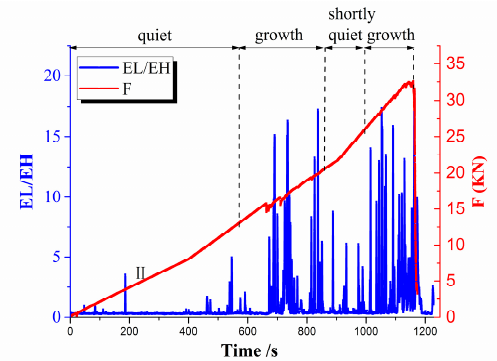
Figure 26. Energy ratio of low-frequency and high-frequency components in Exp. Y1.